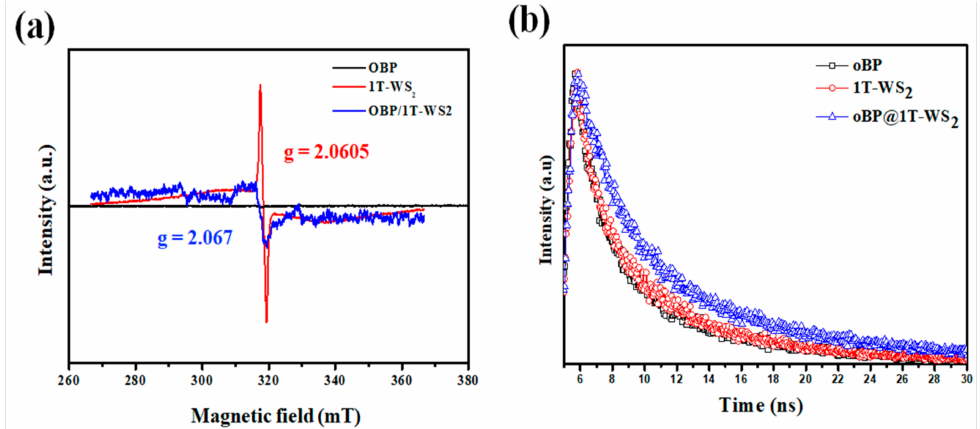
Figure 9. ( a ) CW-EPR spectra of samples recorded at 123.15 K. ( b ) time-resolved photoluminescence spectra (Exitation wave = 470 nm) of OBP, 1T-WS 2 and OBP/1T-WS 2